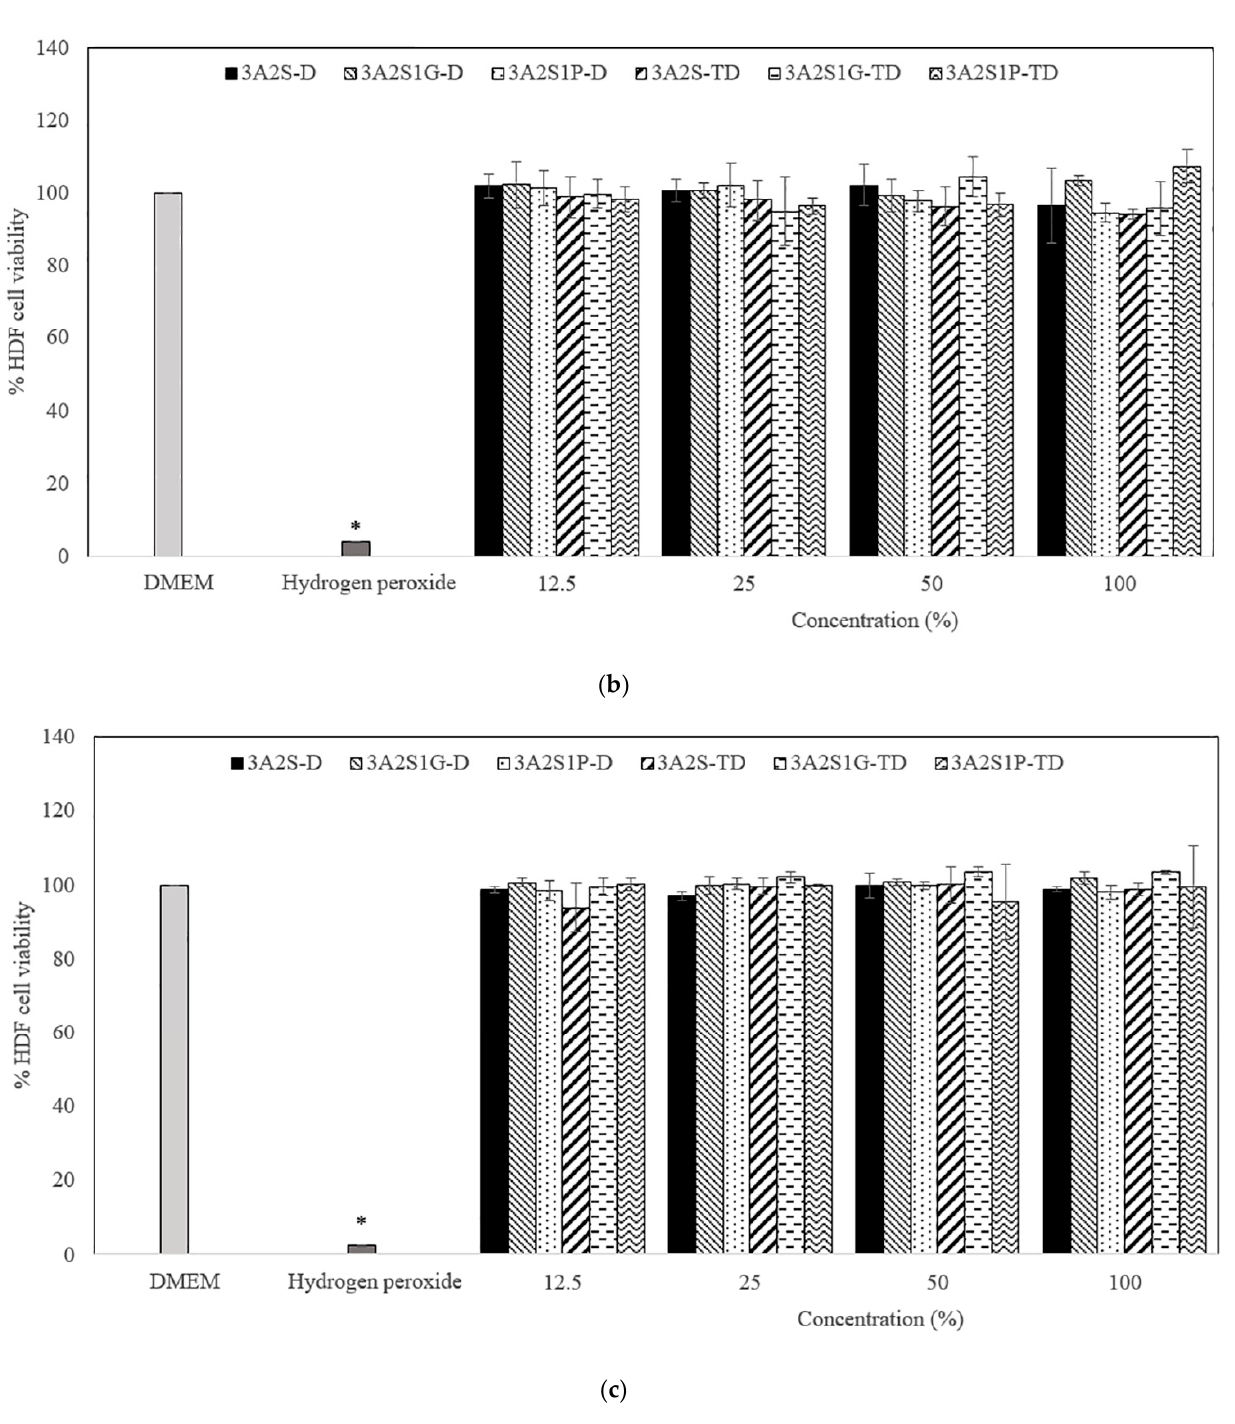
Figure 8. The percentage viability of HDF cells after treatment with different concentrations (12.5%, 25%, 50%, and 100%) of the released scaffolds (3A2S, 3A2S1G, 3A2S1P) that were prepared by the freeze-drying method (D) and by freeze-thawing together with the freeze-drying method (TD) at ( a ) 24 h, ( b ) 48 h, and ( c ) 72 h (* significant difference compared to other samples; p < 0.001).